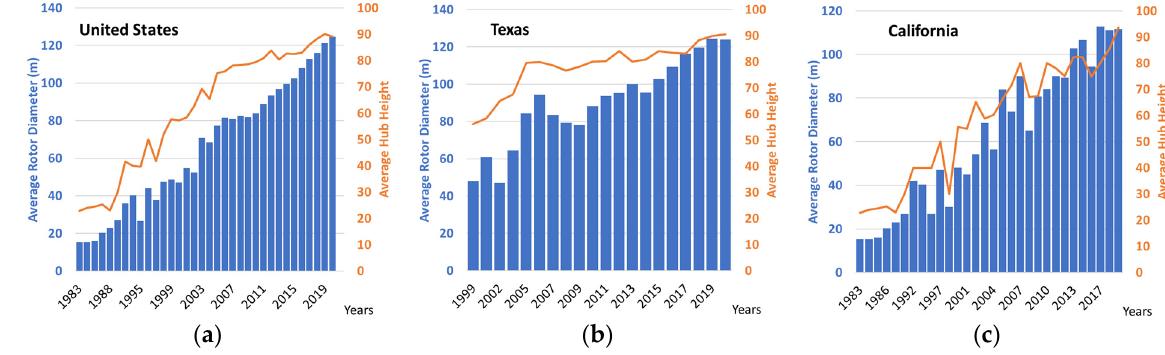
Figure 7. Average rotor diameter (meters) and average hub height (meters) through time in ( a ) the United States, ( b ) Texas and ( c ) California.